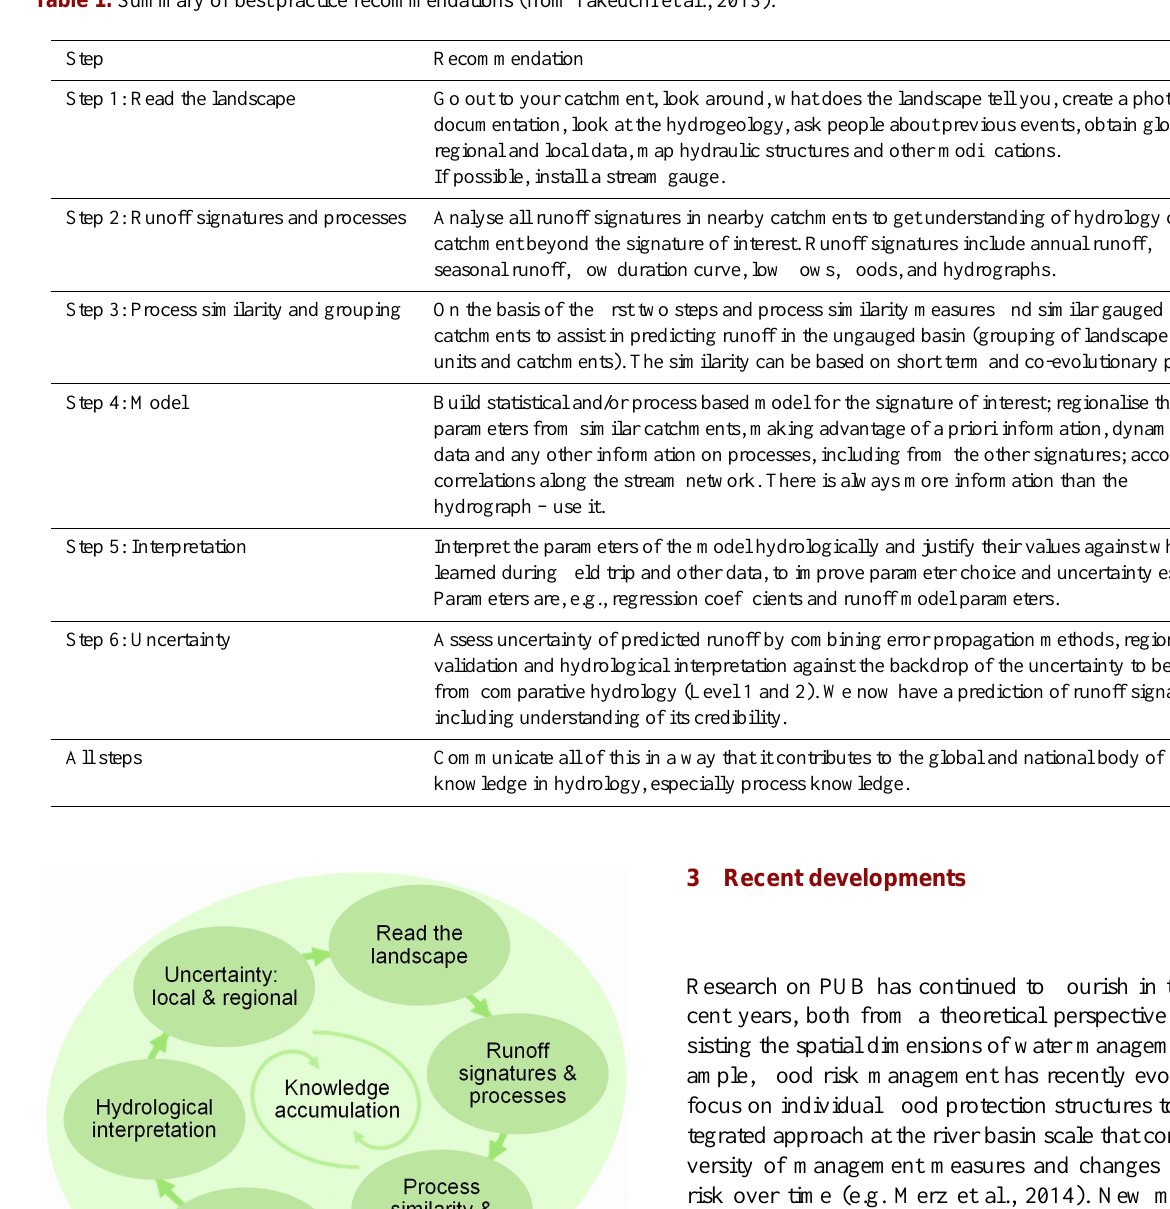
Table 1. Summary of best practice recommendations (from Takeuchi et al., 2013).